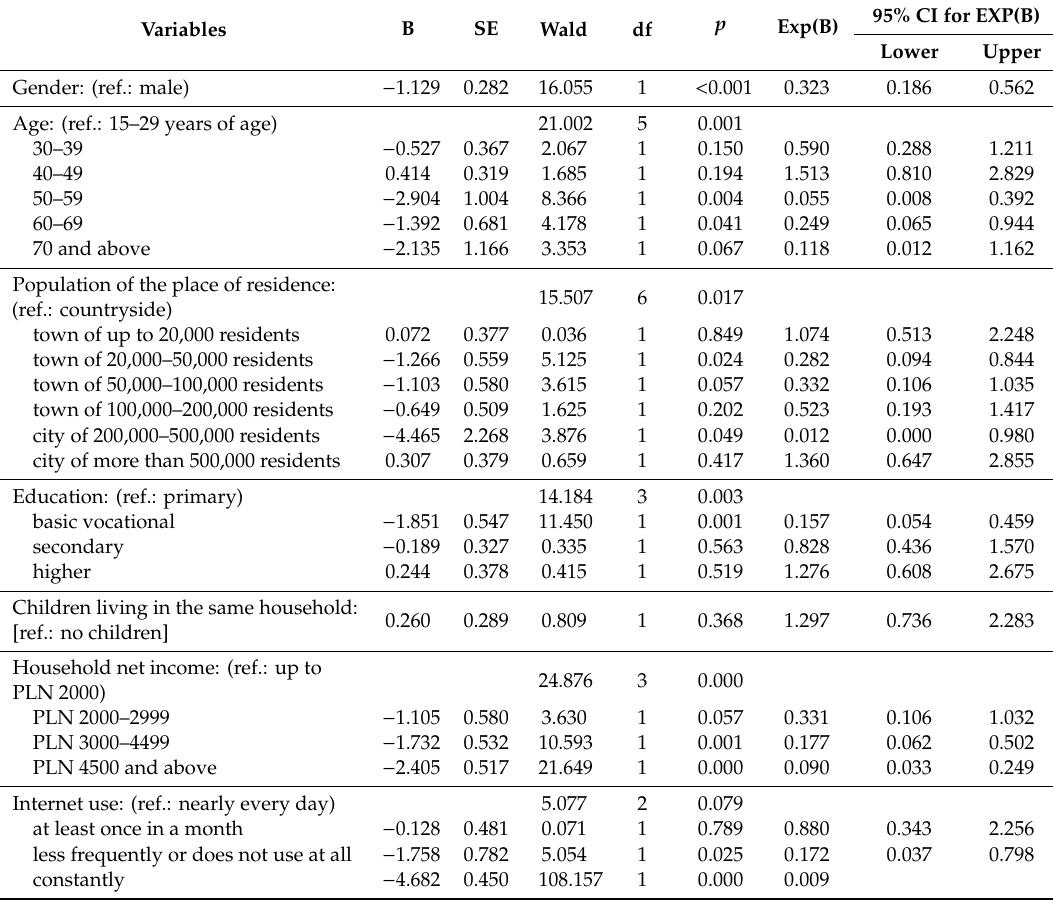
Table 3. An explanatory model of e-gambling ( n =